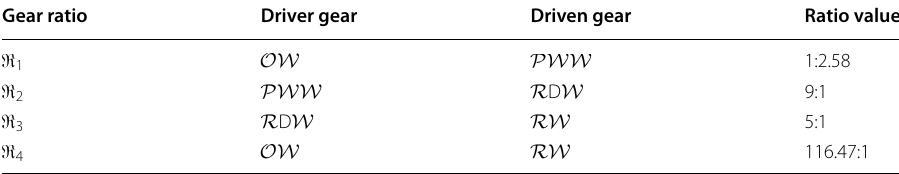
Table 2 Gear ratio values Gear ratio Driver gear Driven